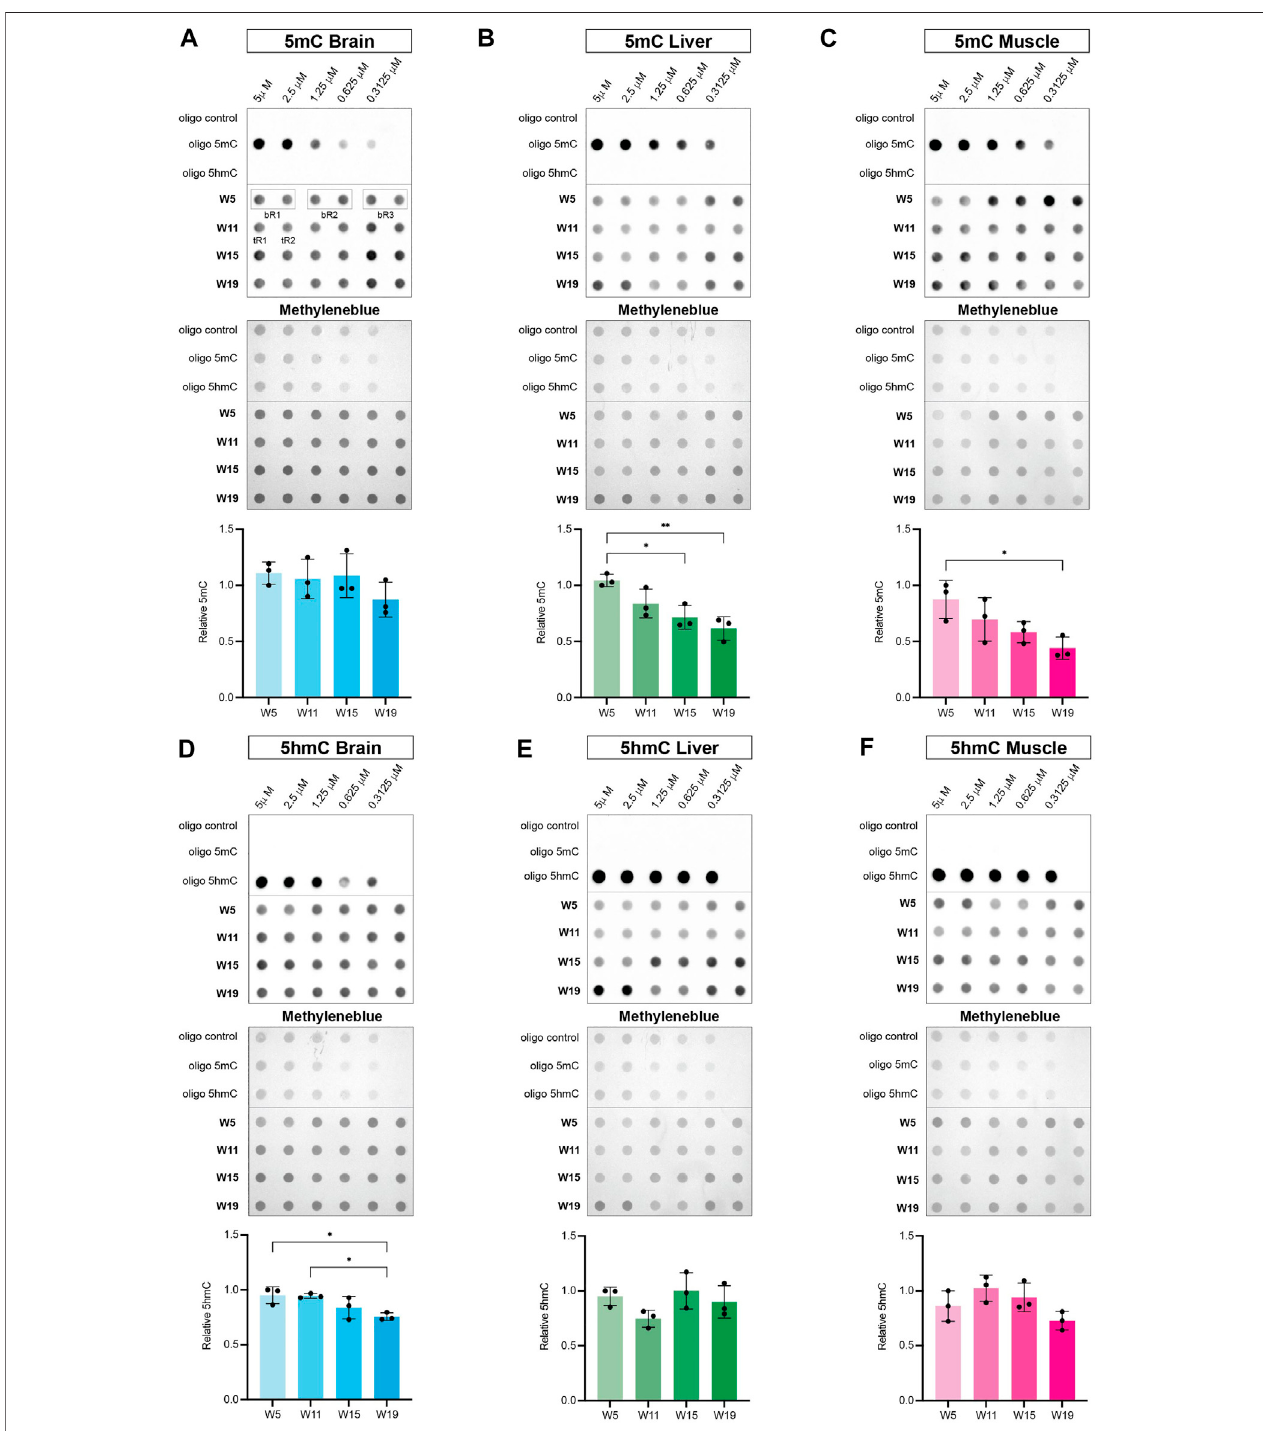
FIGURE 7 | Dynamics of global DNA methylation (A – C) and DNA hydroxymethylation (D – F) in brain, liver, and muscle during the killi fi sh aging process. Dot blot of modi fi ed control oligonucleotides in a 1:2 dilution series starting at 5 μ M (unmethylated: oligo control, 5-methylated CpG: oligo 5mC and 5-hydroxymethylated CpG: oligo 5hmC) (upper panel) and genomic DNA isolated from brain, liver and muscle at 5 (W5), 11 (W11), 15 (W15), and 19 (W19) weeks of age (lower panel) spotted in biologicaltriplicates(bR1,2,3)composedoftwotechnicalreplicates(tR1,2).Themembranewasprobedwithprimaryantibodiesagainst5mCand5hmCfollowed byincubationwithsecondaryantibodies(anti-rabbit/anti-mouseIgG-HRP).Levelsof5mCand5hmCwerenormalizedtotherespectivemethylenebluesignalintensities and calculated as mean of three biological triplicates per time point. Statistical signi fi cances were calculated with one-way ANOVA and multiple comparisons were performed by comparing W11, W15 and W19 to W5 setting one biological replicate to 1. ns: p > 0.05; *: p ≤ 0.05; ** p ≤ 0.01; ***: p ≤ 0.001; ****: p ≤ 0.0001.